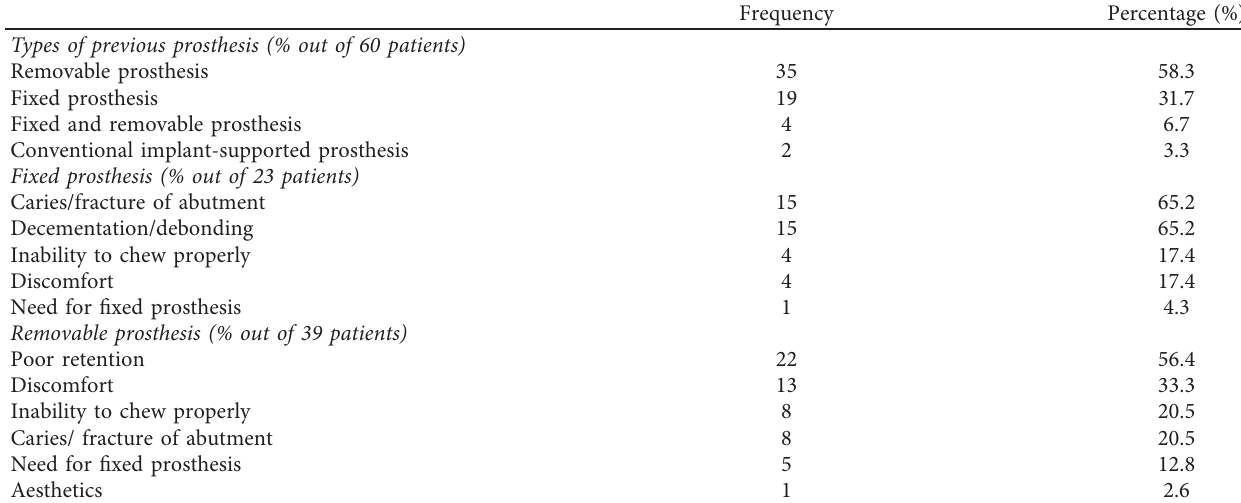
Table 3: Participants’ previous prosthesis type (fixed/removable/conventional implant) and reasons for changing to new basal